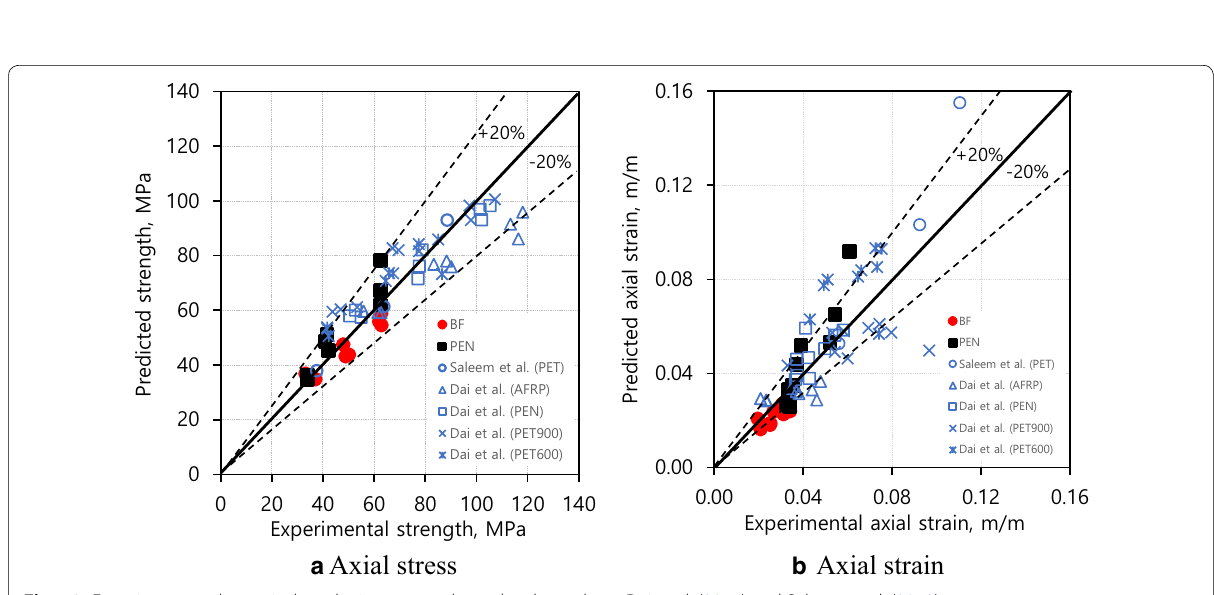
Fig. 19 Experiment vs. theoretical prediction: merged test data by authors, Dai et al. (2011) and Saleem et al.